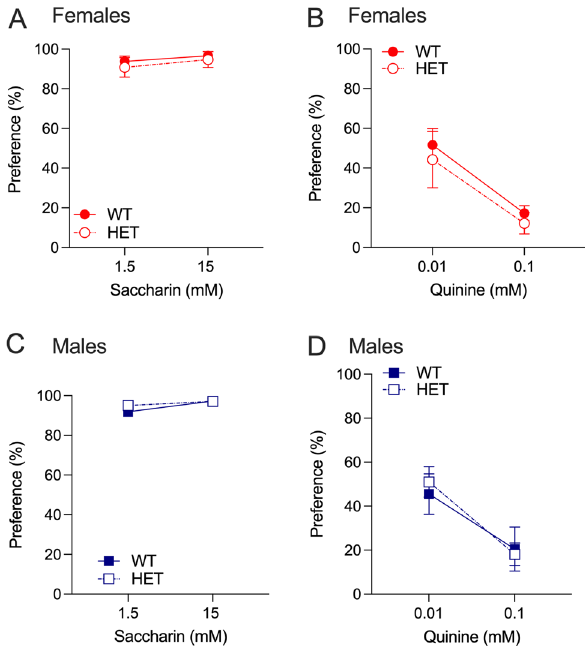
Figure 6. Saccharine and quinine consumption and preference in Slc39a8 WT and HET mice. Female Slc39a8 WT and HET mice showed no significant differences in ( A ) saccharine or ( B ) quinine preference. Male Slc39a8 WT and HET mice also showed no significant differences in ( C ) saccharine or ( D ) quinine preference. Data are presented as mean ± SEM, n = 5–8 female mice per genotype, n = 7–10 male mice per